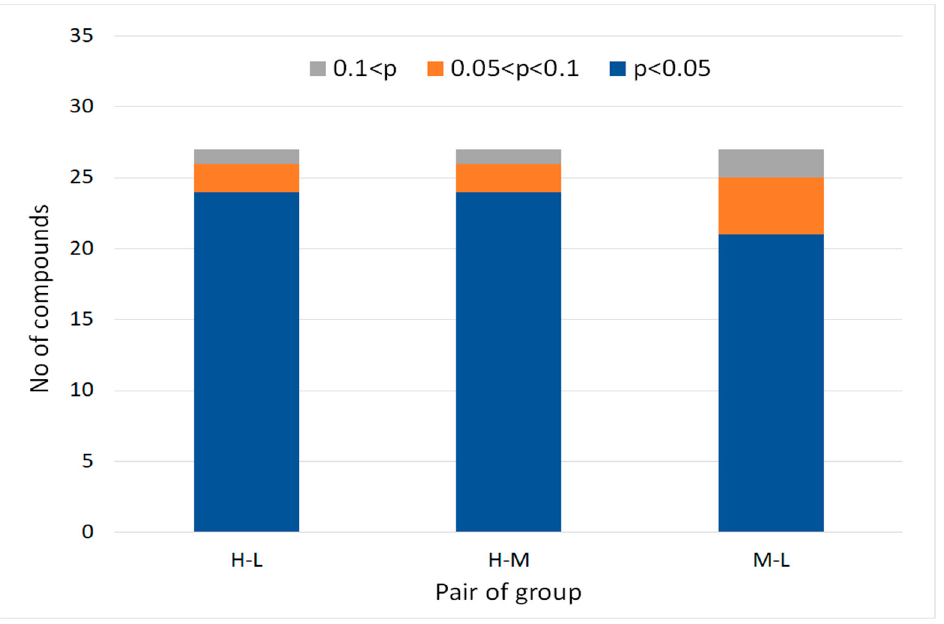
Figure 6. Number of model compounds found in each group. Group H represents the higher concentrations, 30 nL/L and 100 nL/L in 4 different samples. Group M represents the medium concentrations, 3 nL/L and 10 nL/L in 4 different samples. Group L represents the low concentrations: 0.3 nL/L and 1 nL/L. Three different comparisons are shown: H-L, H-M, and M-L. The blue color represents p -value lower than 0.05, the orange represents p -value higher than 0.05 and lower than 0.1, and the gray color represents disqualified compound with p -value higher than 0.1.